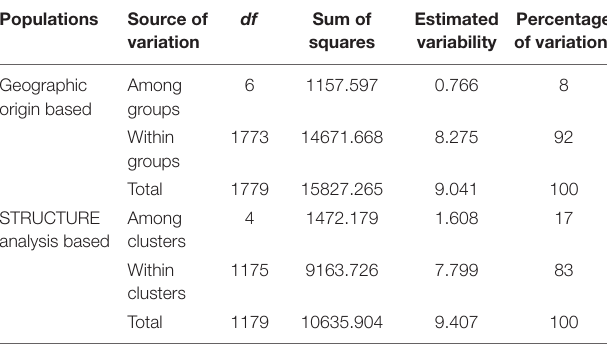
TABLE 5 | Analysis of Molecular Variance based on the 25 SSR markers of studied apricot germplasm. Populations Source of Sum of variation